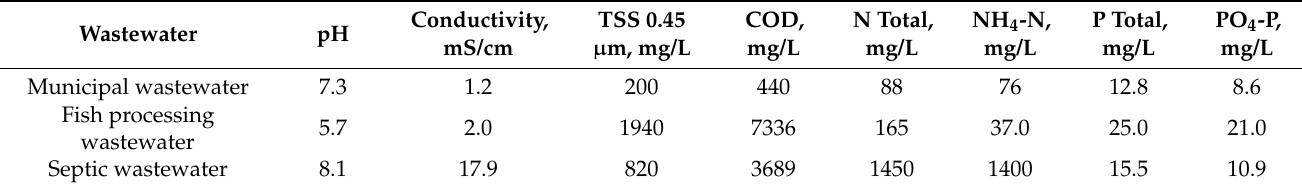
Table 3. Characterization of the wastewater samples.